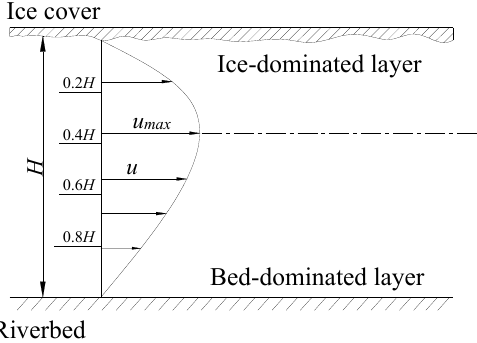
Figure 2. Vertical-flow structure under ice cover.